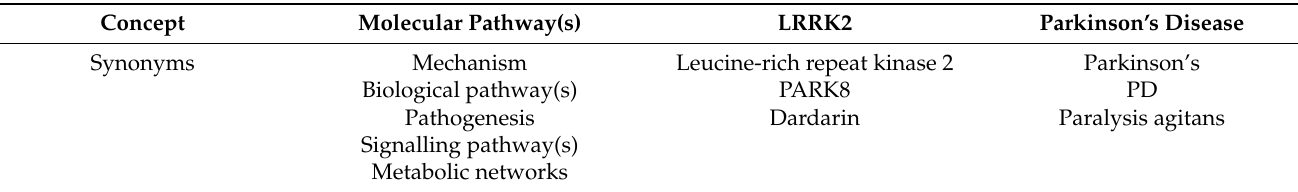
Table 1. Keywords used for the literature